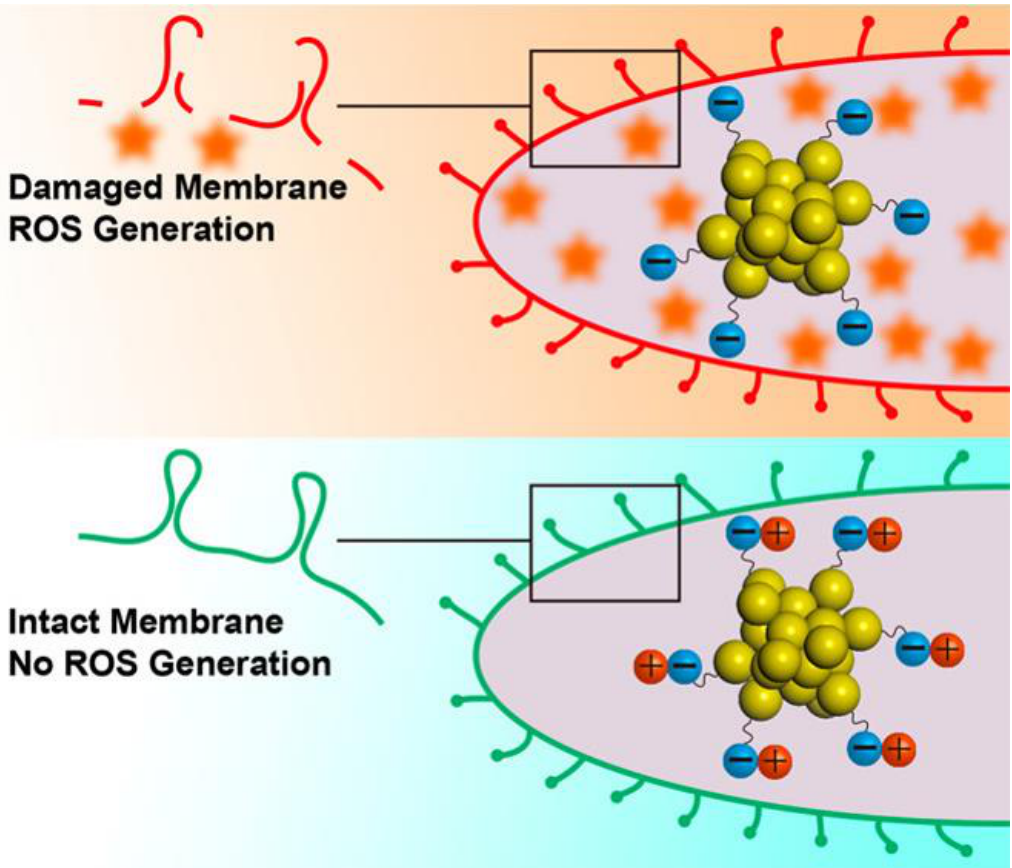
Figure 6. Surface ligand chemistry of AuNCs could determine their antimicrobial ability. Reproduced with permission from Reference [77]. Copyright © 2018, American Chemical Society.